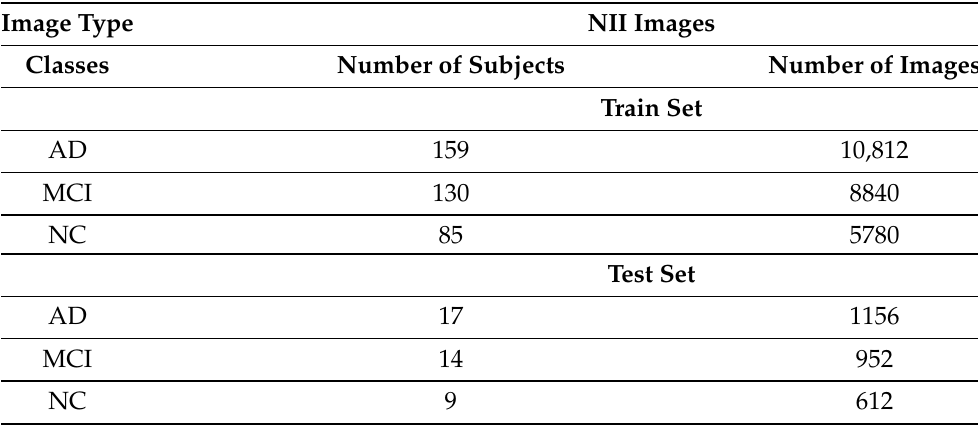
Table 1. Details of the dataset.